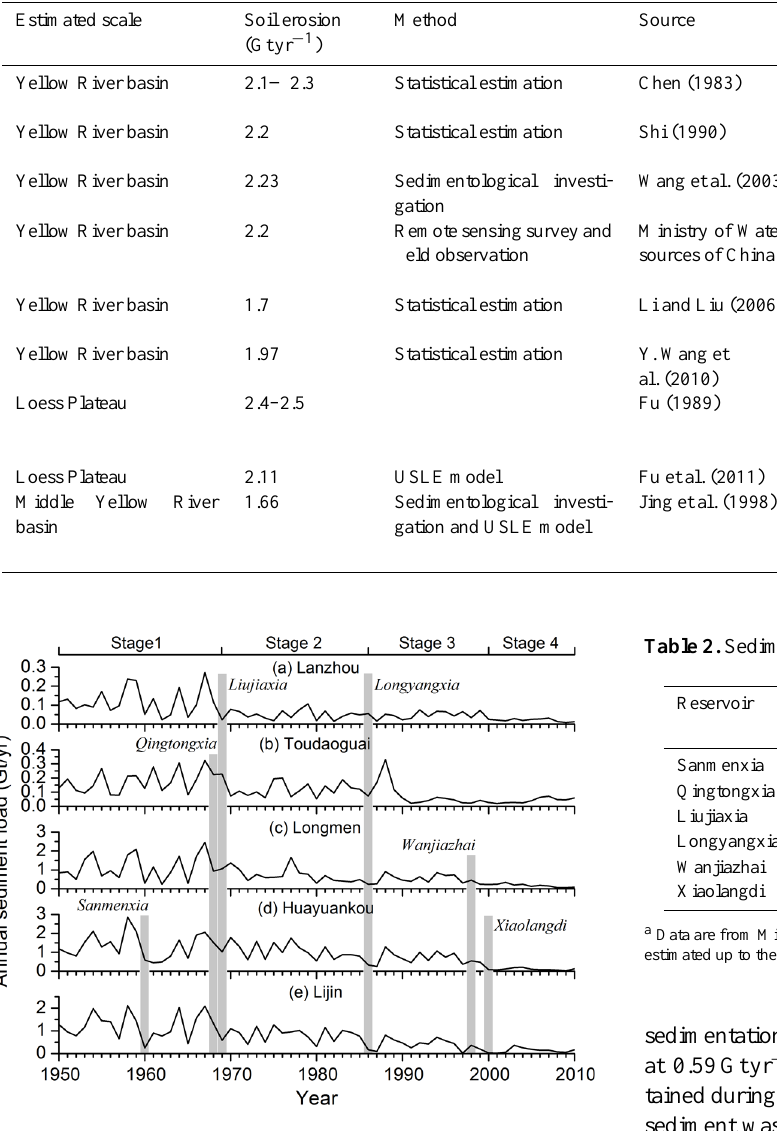
Fig. 3. Temporal variations of sediment load along the main- stem channel: (a) Lanzhou, (b) Toudaoguai, (c) Longmen, (d) Huayuankou, and (e) Lijin. Also shown are large mainstem reser- voirs (refer to Fig. 1 for locations). Data are from the Yellow River Conservancy Commission (http://www.yellowriver.gov.cn/).